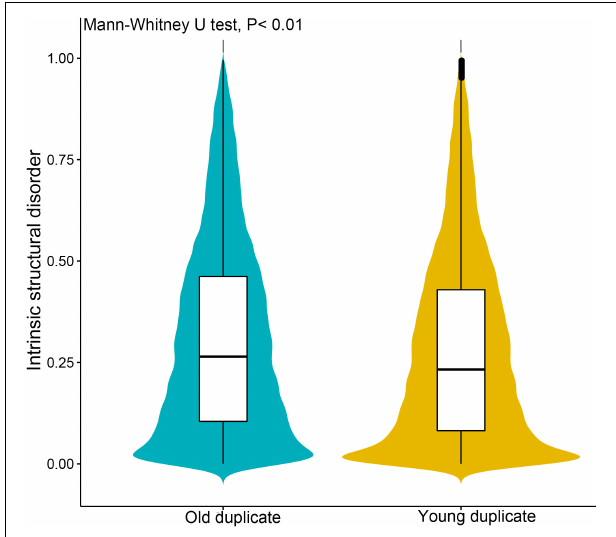
FIGURE 1 | Comparison of intrinsic structural disorder (ISD) between young and old duplicate genes in Vernicia fordii . IUPred2A was used to estimate the ISD value with default parameters.